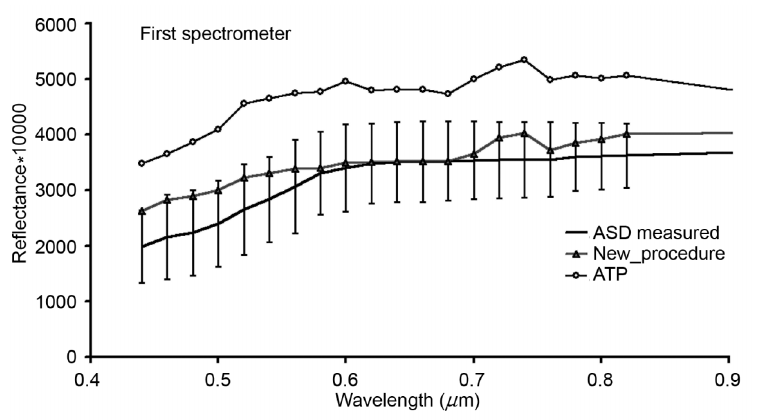
Fig. 5. Comparison of APT and new calibration spectrum of the AOI in concrete with respect to ASD re- flectance. ASD measure is graphed with one sigma errors